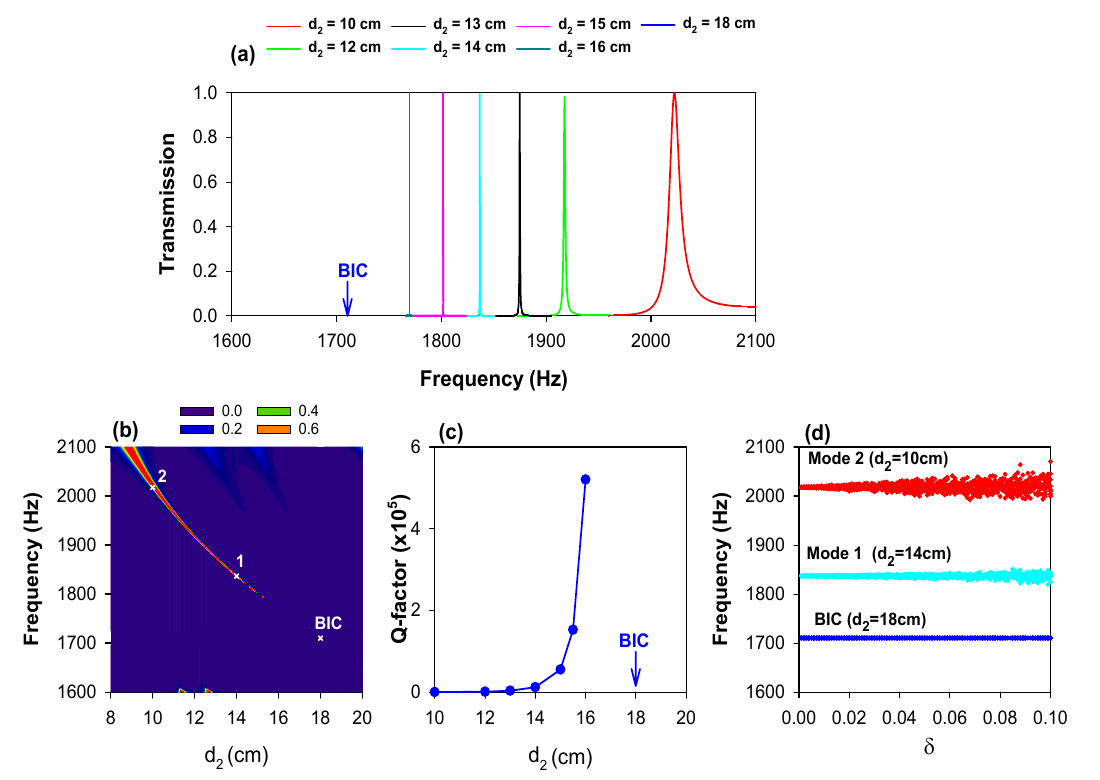
Figure 8. ( a ) Transmission spectra for certain values of d 2 around d BIC and a fixed d 1 = 2 cm (PnC1). 2 ( b ) Variation of the transmission coefficient as a function of d 2 and frequency in the first common bandgap. The crosses indicated by 1, 2 and BIC give the values of d 2 for which the effect of disorder is discussed in panel ( d ). ( c ) Quality factor of the interface states deduced from the width of the resonances in ( a ) as a function of d 2 . ( d ) Evolution of the interface modes marked by crosses in panel ( b ) for 10 realizations of disorder by varying the disorder strength δ : BIC (blue curve), mode 1 (cyan curve) and mode 2 (red